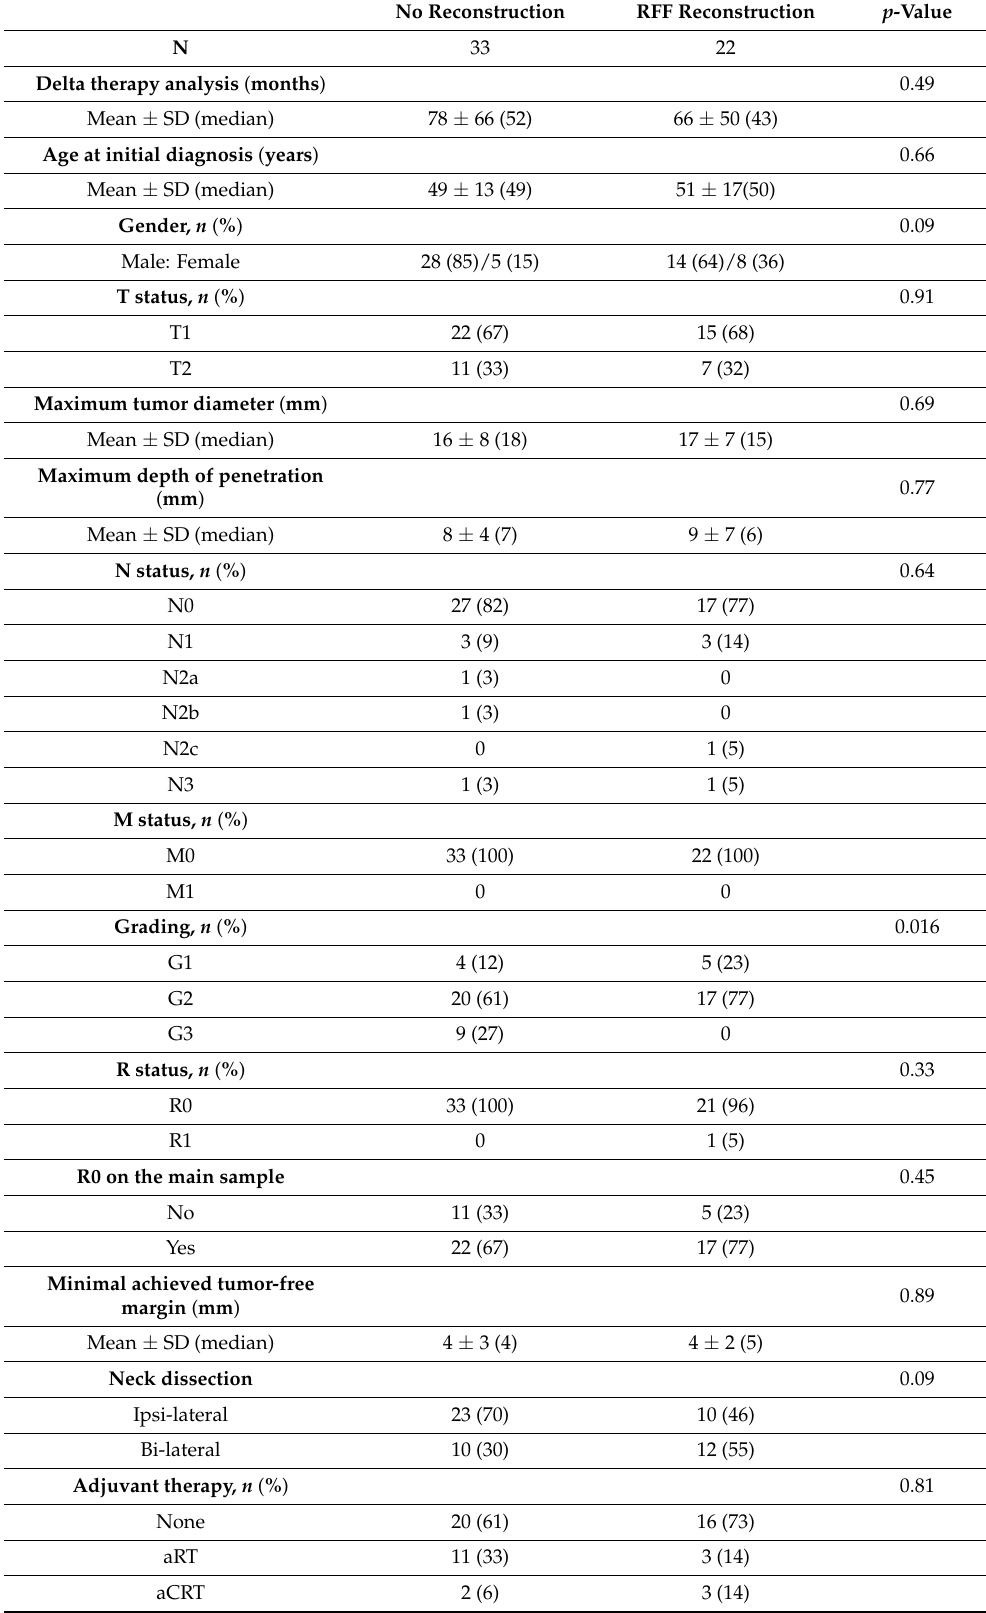
Table 5. Epidemiologic data of the functionally analyzed